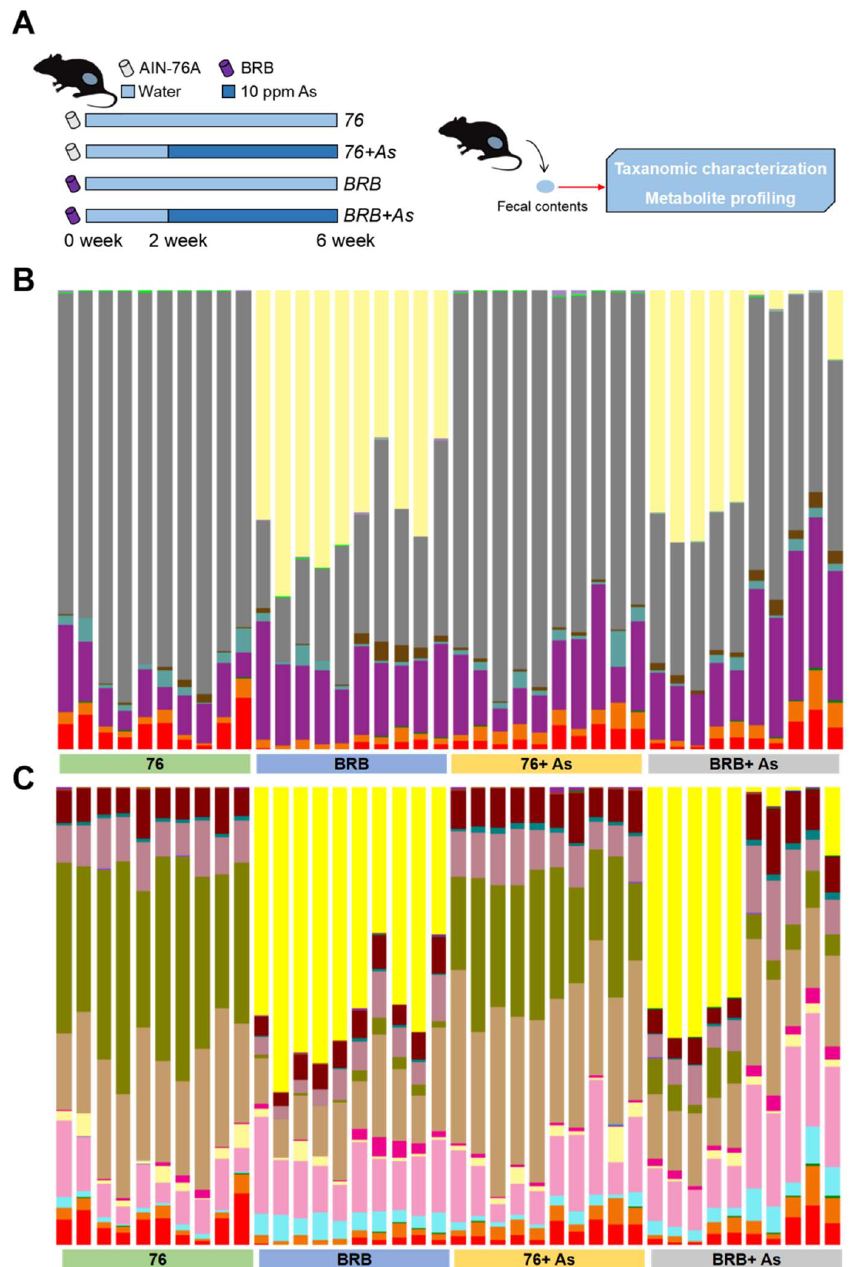
Figure 1. Taxonomic summaries of mouse gut microbial communities. ( A ) Experimental design. ( B ) Taxonomic summary at order level. ( C ) Taxonomic summary at family level (legend at Figure S2).